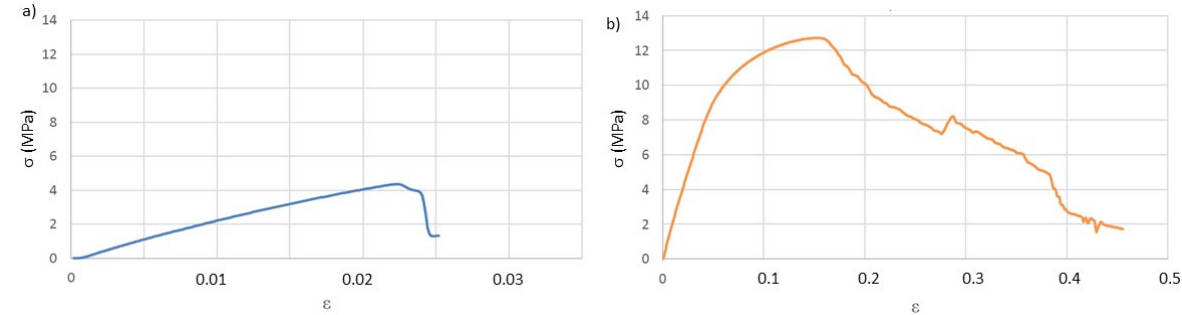
Figure 6. Representative stress-strain curves after aging in AS (artificial saliva): ( a ) T and ( b ) P h . Table 5. Mean and standard deviation values of the mechanical properties calculated from the tensile tests of the PCL (poly( ε -caprolactone)) specimens after aging in AS.